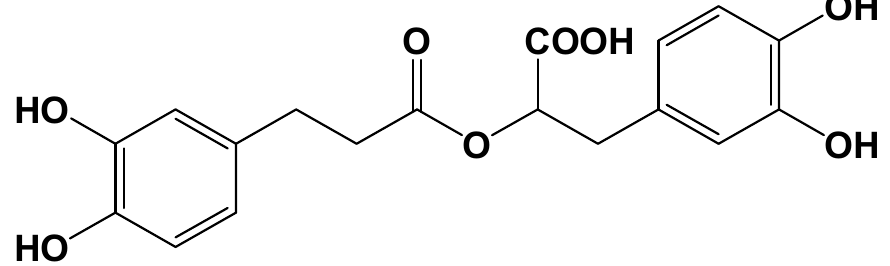
Figure 1. The structure of rosmarinic acid.